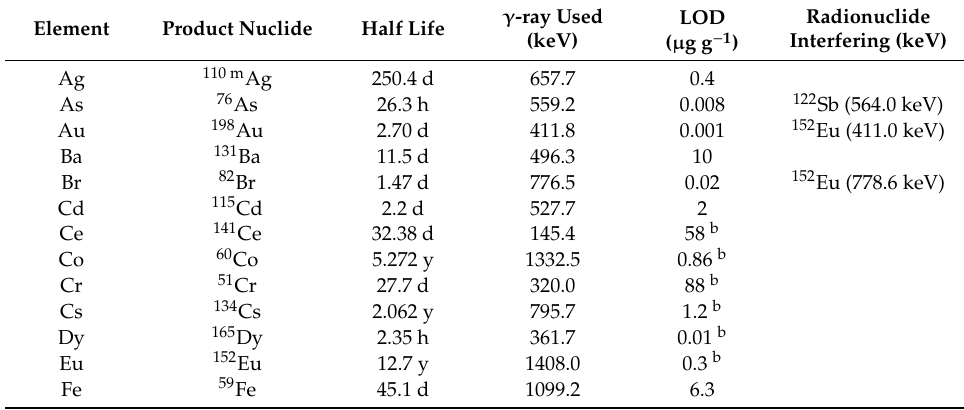
Table 1. Nuclear data and limit of detection (LOD) of each element determined by instrumental neutron activation analysis